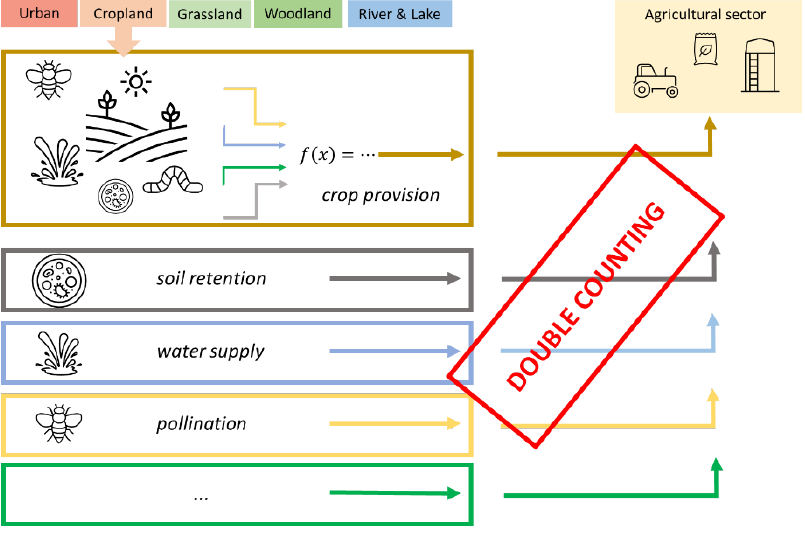
Figure 2. Crop provision accounting with the risk of double counting.